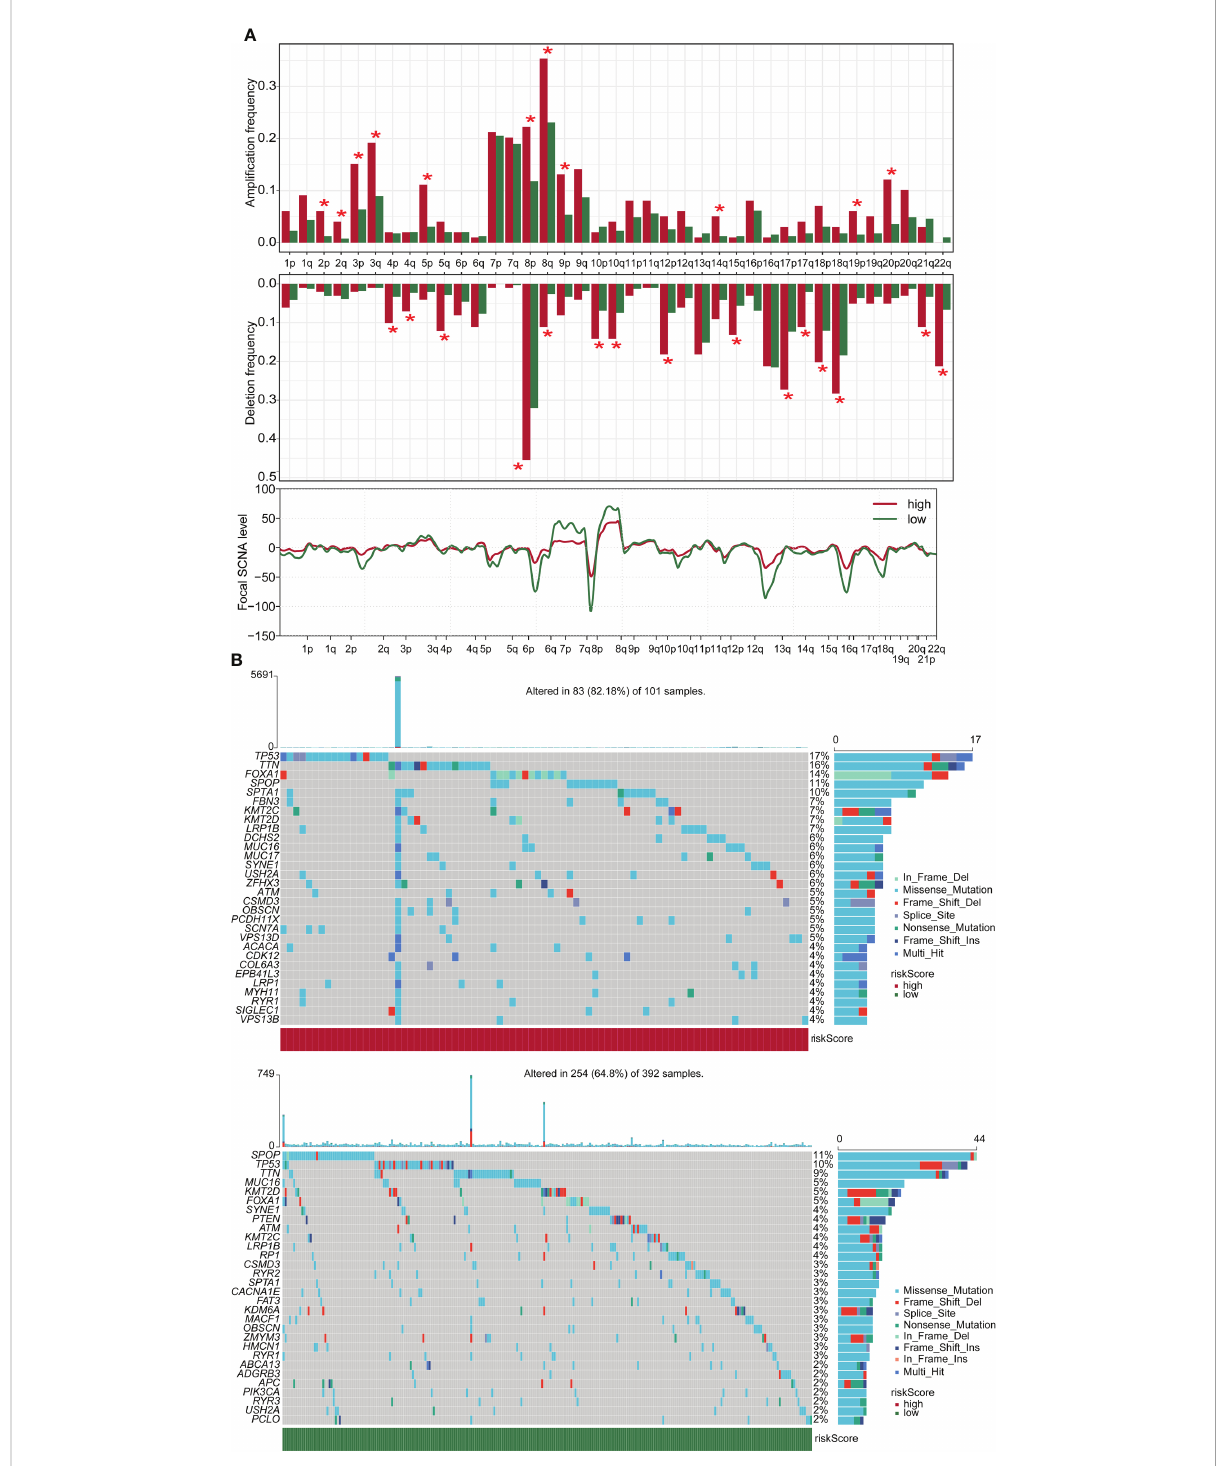
FIGURE 5 CNV and mutation analysis in high- and low-score groups. (A) CNV maps for groups with high and low score. (B) Top 30 gene mutation frequencies in two groups. CNV, copy number variation. *p <